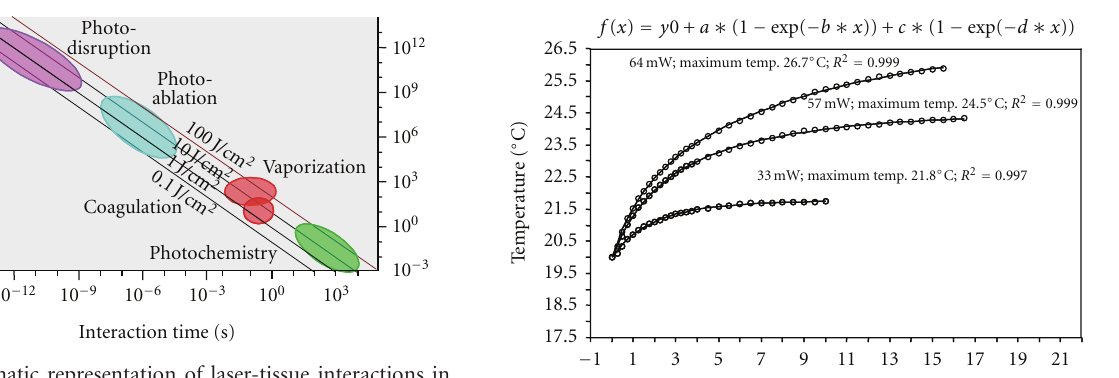
Figure 1: Schematic representation of laser-tissue interactions in relation to exposure time and input energy.